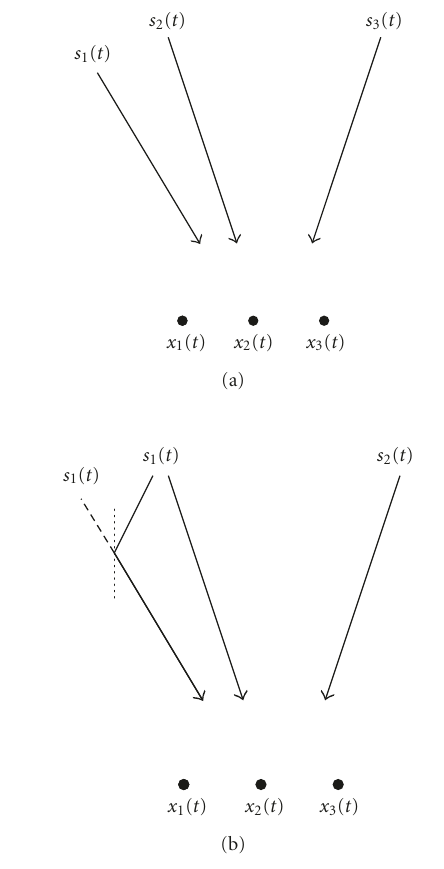
Figure 1: 3 sensors pick up 3 anechoic mixtures of 3 signals (a) and 3 echoic mixtures of 2 signals